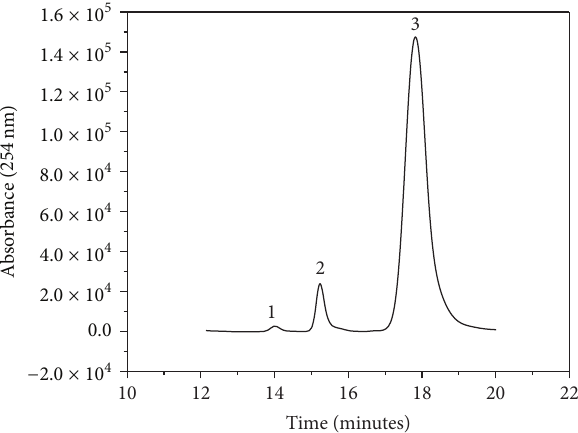
Figure 5: Michaelis-Menten hyperbole ( 𝐾 𝑀 ) for Tc NTPDase-1- ICER.